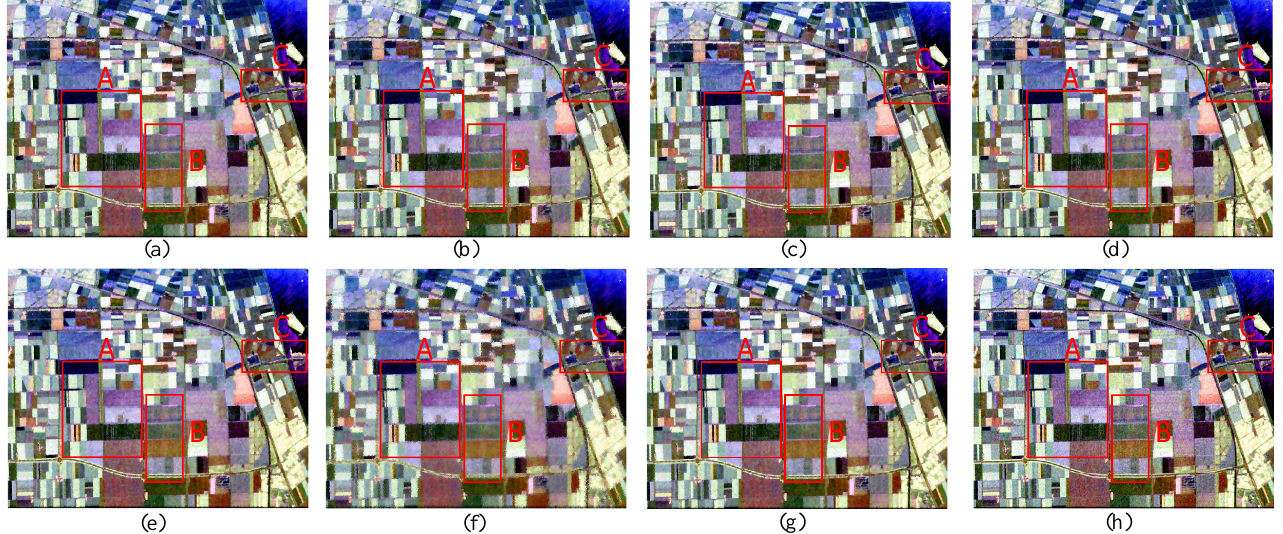
Figure 12. Quantitative evaluation results of the AIRSAR data set. ( a ) POL-SLIC. ( b ) POL-LSC. ( c ) POL-HLT. ( d ) WS. ( e ) HAWS. ( f ) HAGS. ( g ) The proposed HCI. ( h ) Pauli-RGB image. For these methods, the weighting factor of POL-LSC is set as 0.3, the compactness parameter m is set as 0.1 for POL-SLIC, 0.7 for POL-HLT, 0.4 for WS and HAWS, and 0.1 for HAGS. Because RWD and GD are adopted by the proposed HCI, the compactness parameters m CI _ RW = 0.4 and m CI _ GD = 0.1 for HCI. Figure 12 shows that the proposed HCI performs best with the smoothest boundary of superpixels. The performance of these six competitive algorithms on the real-world PolSAR image is evaluated by visual observations and quantitative evaluation, in which region A, indicated by the red rectangle, is selected for quantitative evaluation. Figure 13 shows the corresponding quantitative evaluation, and the generated superpixels of region A are shown as Figure 14. The BR of POL-SLIC and POL-LSC is much lower than that of the other algorithms, and the BR of POL-LSC decreases obviously with increasing S . This means that the performance of POL-LSC in generating superpixels is quite unstable, which is disadvantageous for the superpixel generation of PolSAR images. Figure 13a shows that the proposed HCI, HAWS and POL-HLT obtain a higher BR than other algorithms; admittedly, the RT of the proposed HCI is 12% and 31% faster than that of HAWS and POL-HLT, as shown in Figure 13b, because of the adoption of GD by HCI.